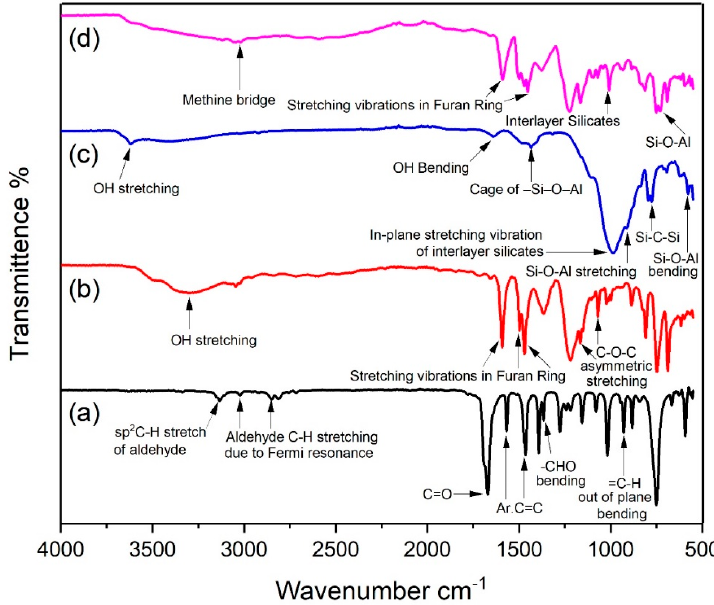
Figure 2. FTIR spectra of: ( a ) Furfural extracted from Saccharum munja; ( b ) Phenol-furfural resin; ( c ) Organo modified MMT clay; ( d ) Phenol-furfural resin/organo modified MMT clay composite.